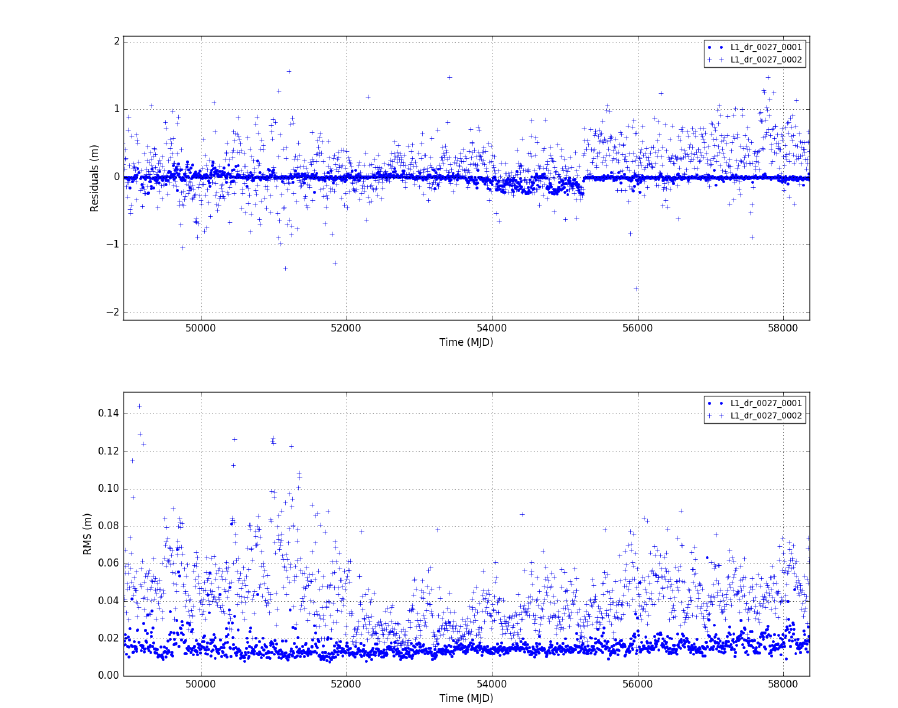
Figure 11. LAGEOS POD results. Top: Range residuals. Bottom: RMS of the range residuals.